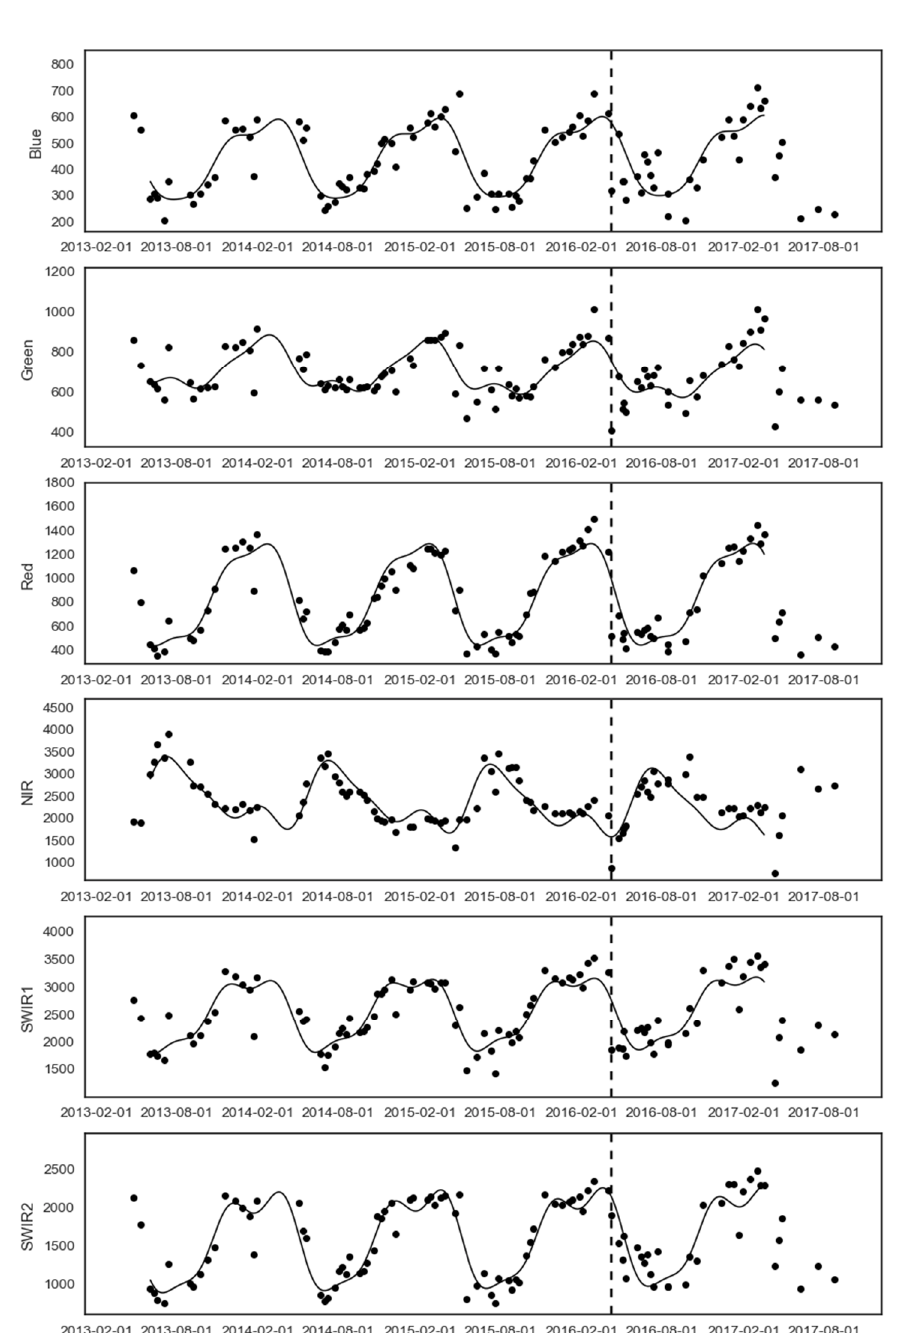
Figure 9. Time series of HLS clear observations (black dots) and CCDC model (solid line). The vertical dashed line shows the fire event (8 April 2016) indicated by the BAECV product. Spectral range of displayed bands are Blue (0.45–0.51 µ m); Green (0.53–0.59 µ m); Red (0.64–0.67 µ m); NIR (0.85–0.88 µ m); SWIR1 (1.57–1.65 µ m); SWIR2 (2.11–2.29 µ m).